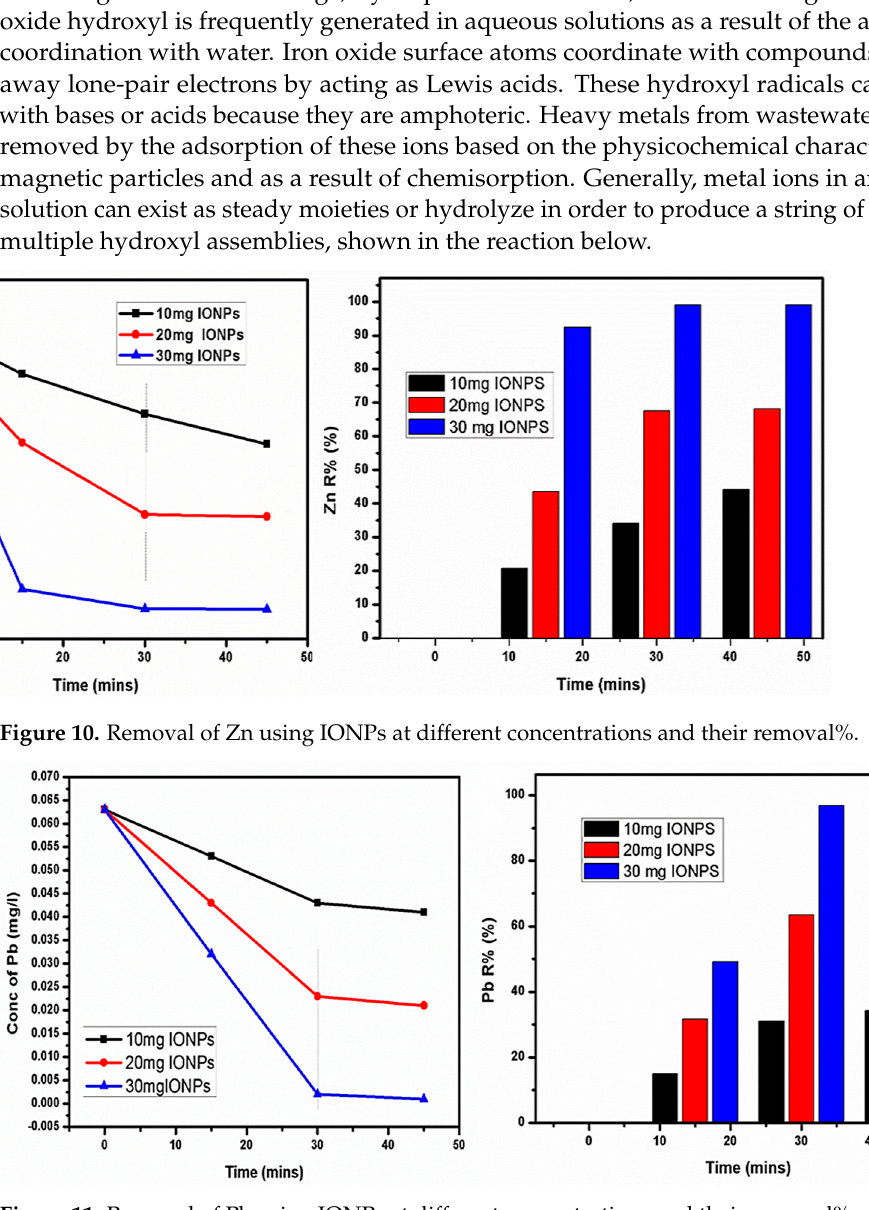
Figure 11. Removal of Pb using IONPs at different concentrations and their removal%.